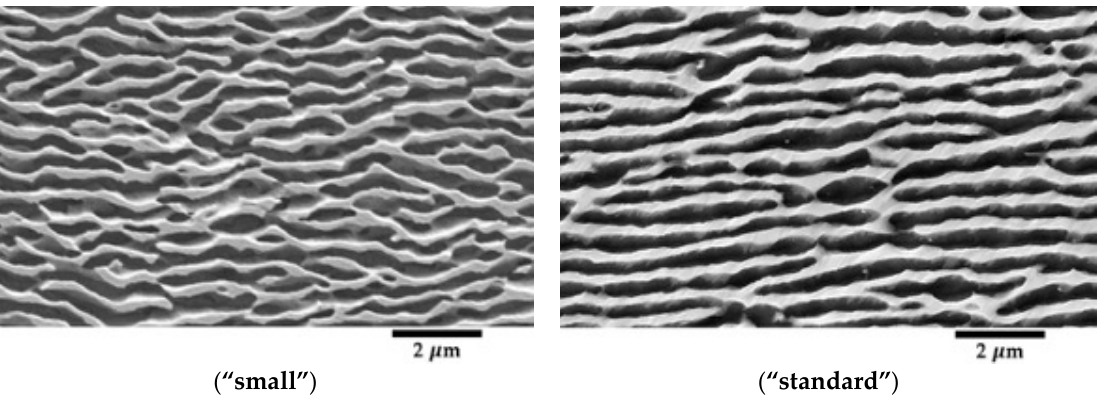
Figure 4. SEM micrographs of two specimens with different initial microstructure at different temperatures: 970 °C (“ small ” microstructure), 1000 °C (“ standard ”).